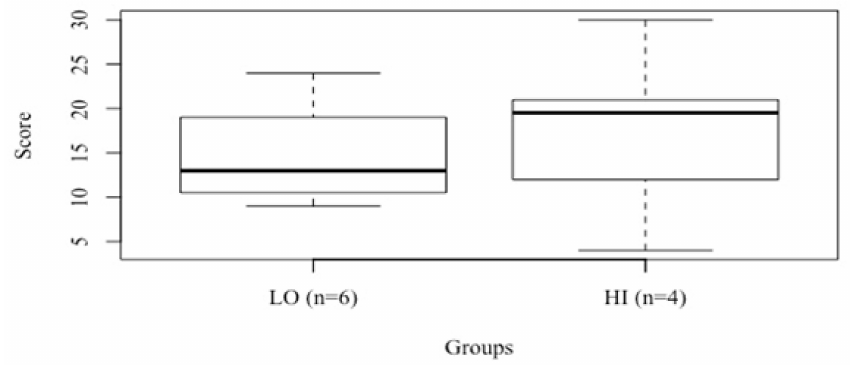
Figure 1. Boxplot visualization of the k-means cluster analysis grouping individuals as either high- performance (HI) or low performance (LO) and showing the minimum score, first quartile, median, third quartile, and maximum score achieved in the simulated competition by every